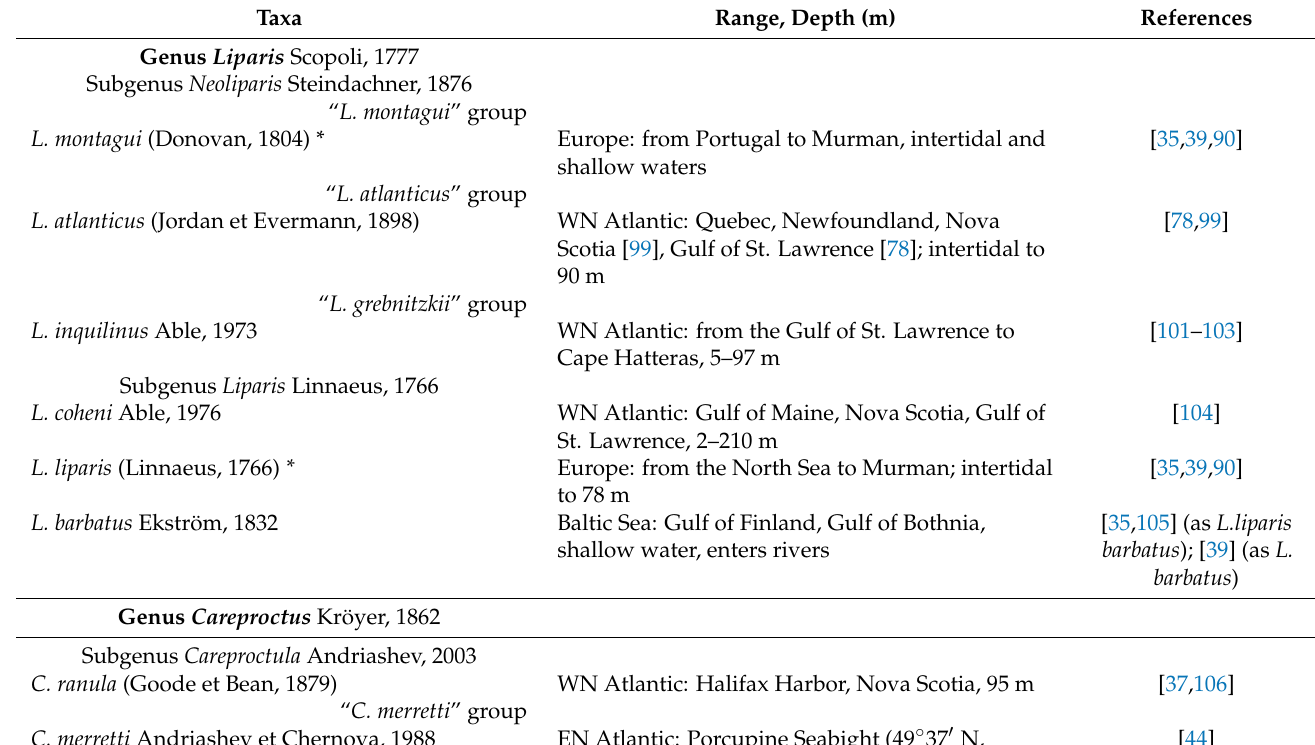
Table 3. List of Liparidae of the North